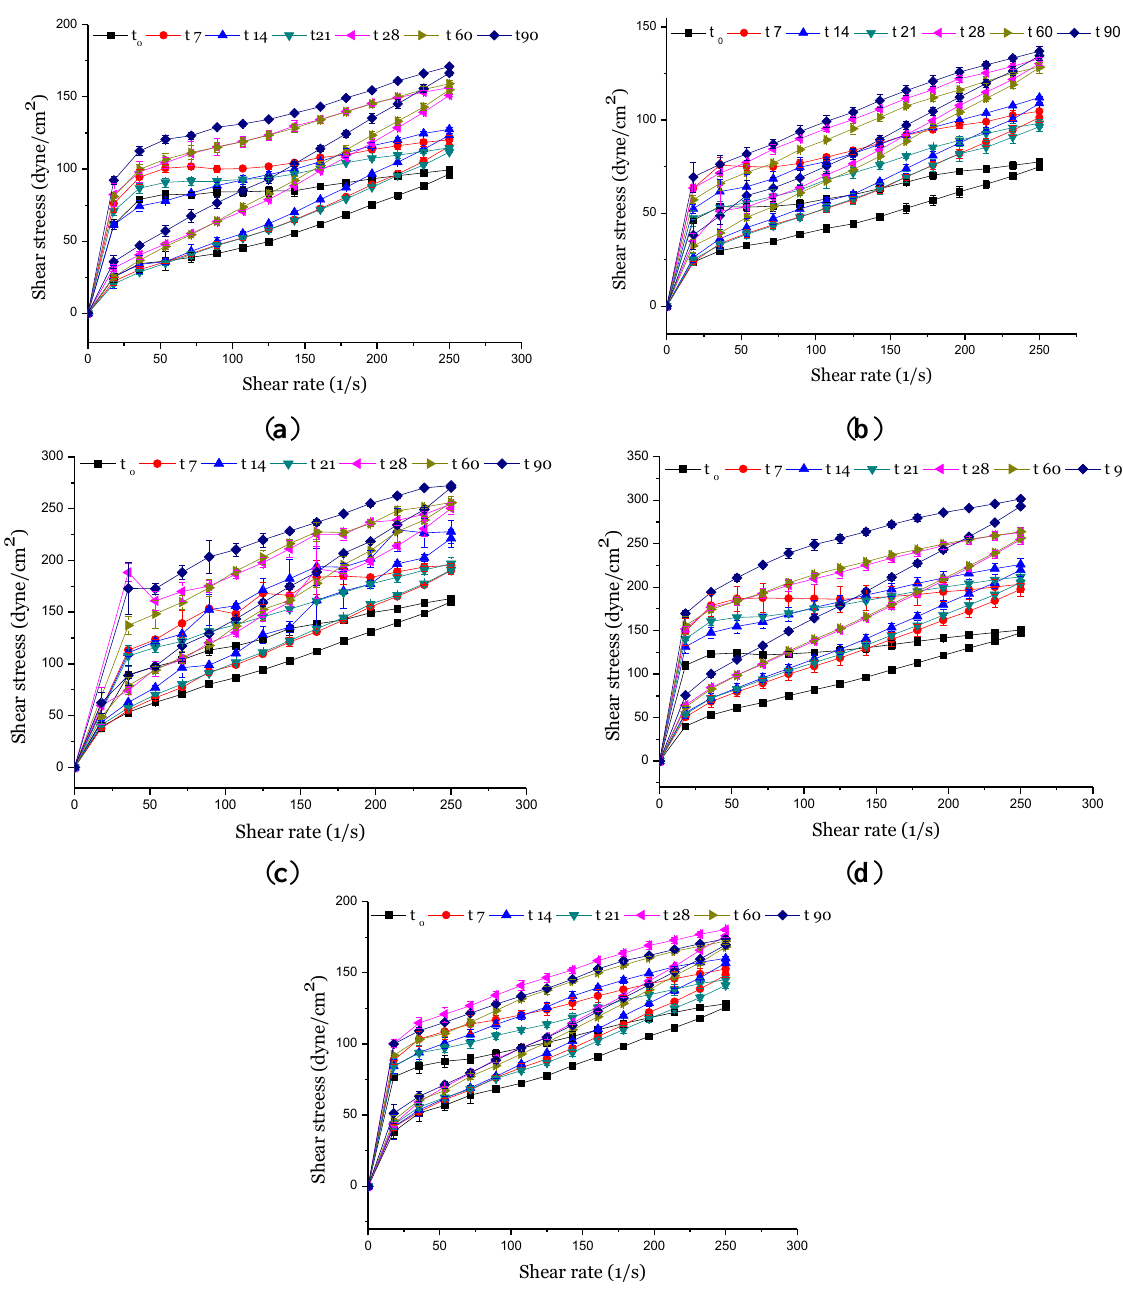
Figure 2. Rheograms of the ( a ) vehicle formulations; ( b ) formulation containing organic UV filters, and supplemented with ( c ) CePO in 0, 7, 14, 21, 28, 60 and 80 days after